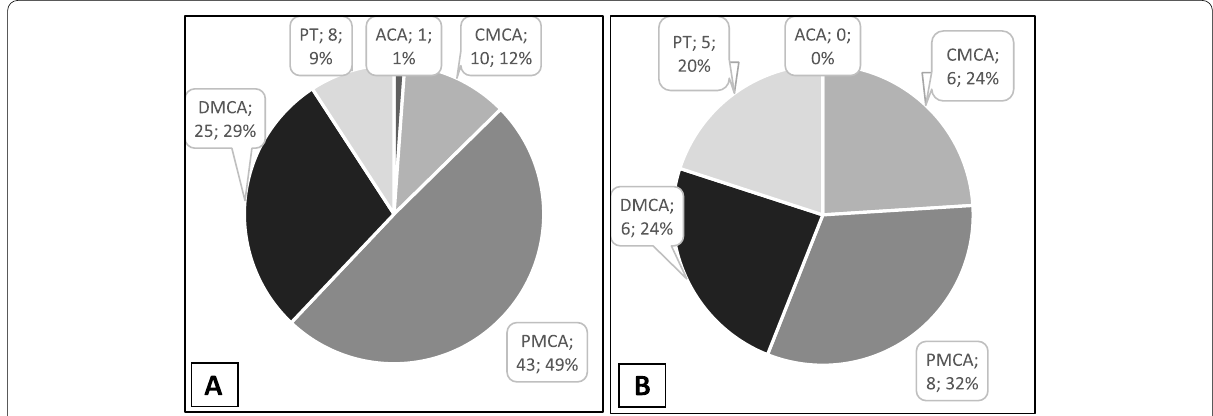
Fig. 2 Distribution of CT scan ischemic lesion in all patients ( A ) and in patients who experienced headache ( B ). ACA: anterior cerebral artery, CMCA: complete middle cerebral artery, PMCA: partial middle cerebral artery, DMCA: deep middle cerebral artery, PT: posterior